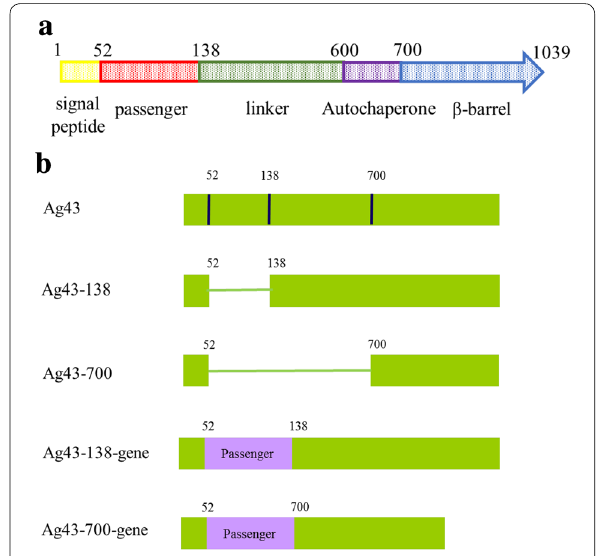
Fig. 2 Schematic representation of the composition of Ag43 and the different fusion sites. a Signal peptide, passenger, linker, autochaperone, and β‑barrel domain are indicated in yellow, red, green, purple, and blue, respectively. b Presentation of two different fusion positions (the 138th aa and the 700th aa) of Ag43 where the passenger proteins